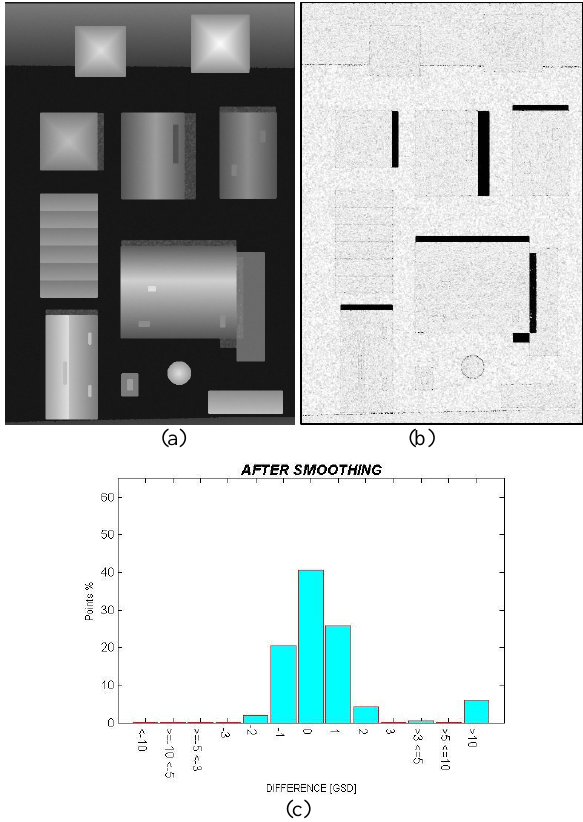
Figure 4: denoised DSM (a), differences between ground truth and the smoothed DSM using the median filter (b) and histogram of the differences (c).